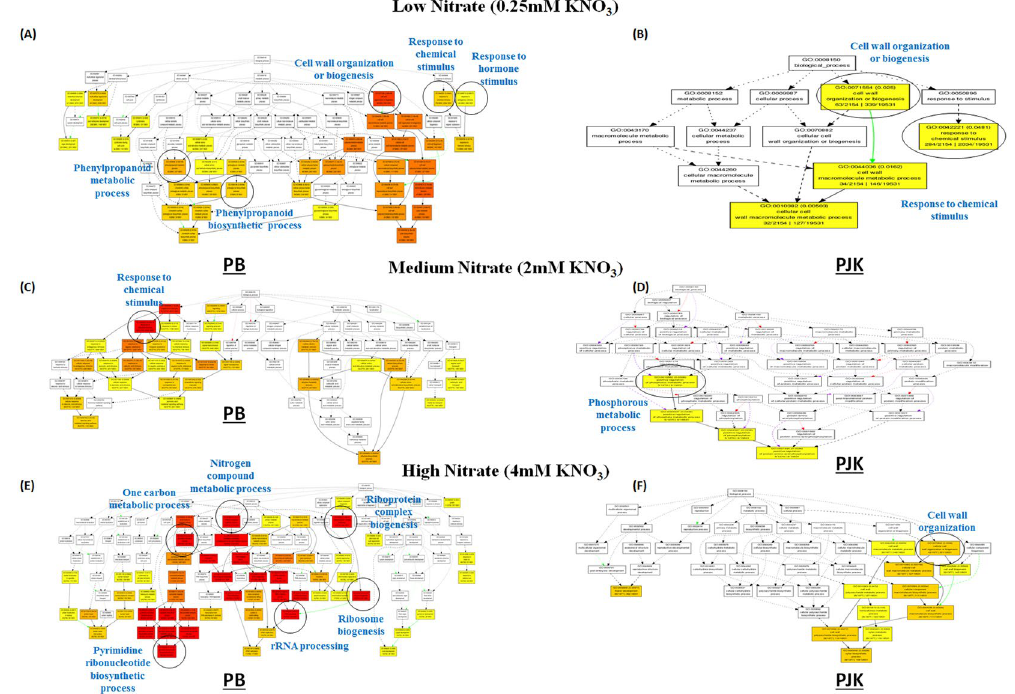
Figure 2. GO biological process enrichment of PB and PJK in response to low (0.25 mM KNO 3 ), medium (2 mM KNO 3 ) and high nitrate treatment (4 mM KNO 3 ): Hierarchical tree graph of overrepresented GO terms in biological function category in response to low ( A , B ), medium ( C , D ) and high nitrate ( E , F ) treatments. Boxes in the graph represent GO terms with their GO ID, term definition and statistical information. Significant GO terms (p ≤ 0.05) are marked with color and non-significant GO terms are shown in white boxes. The degree of color saturation of a box is positively correlated to the enrichment level of the term. Solid, dashed, and dotted lines represent two, one and zero enriched terms at both ends connected by the line, respectively. The rank direction of the graph is set to from top to